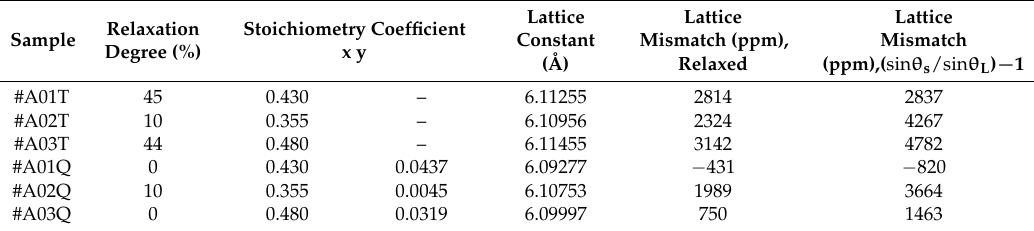
Table 2. Chemical compositions of multicomponent layers. (Reproduced with permission from Jasik et al., Journal of Applied Physics; published by the American Institute of Physics, 2011 [28]).